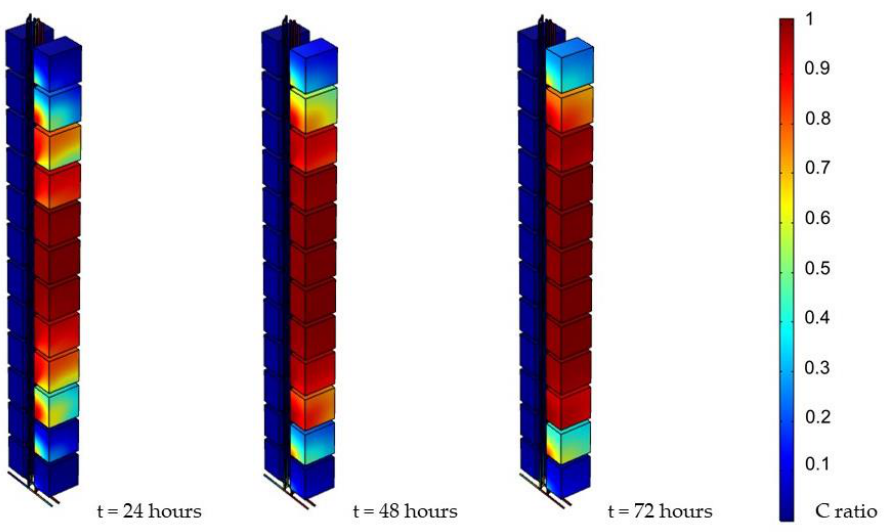
Figure 6. Simulation results (0.05 Pa, 1000 ppm).